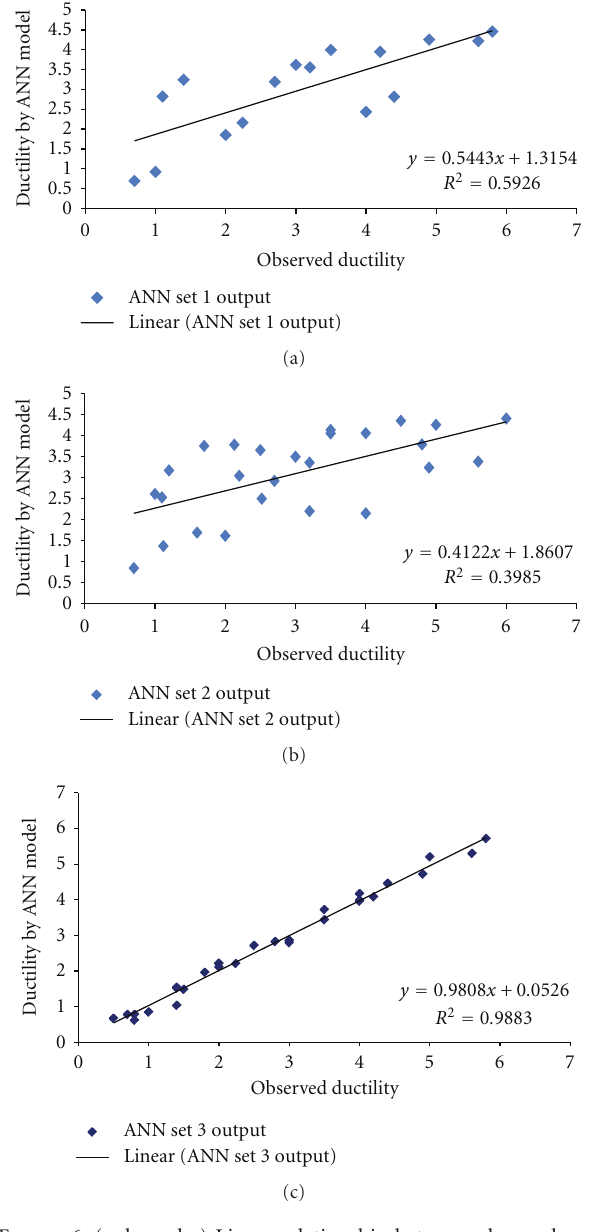
Figure 6: (a, b, and c) Linear relationship between observed and modeled (ANN) ductility for dataset 1, 2 and 3.